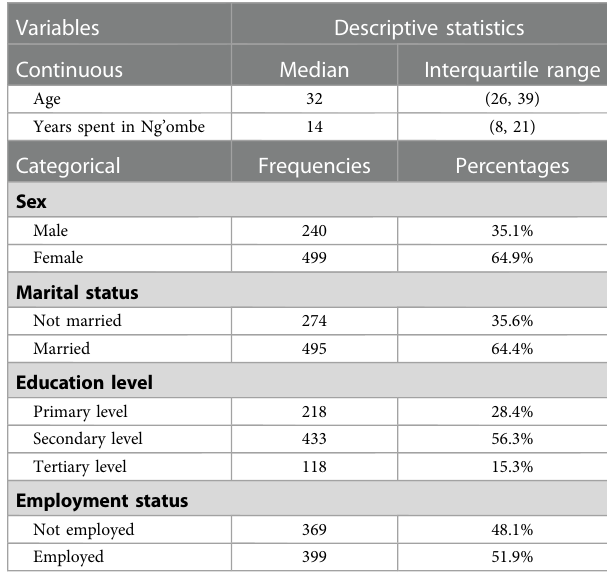
TABLE 1 Background characteristics of the